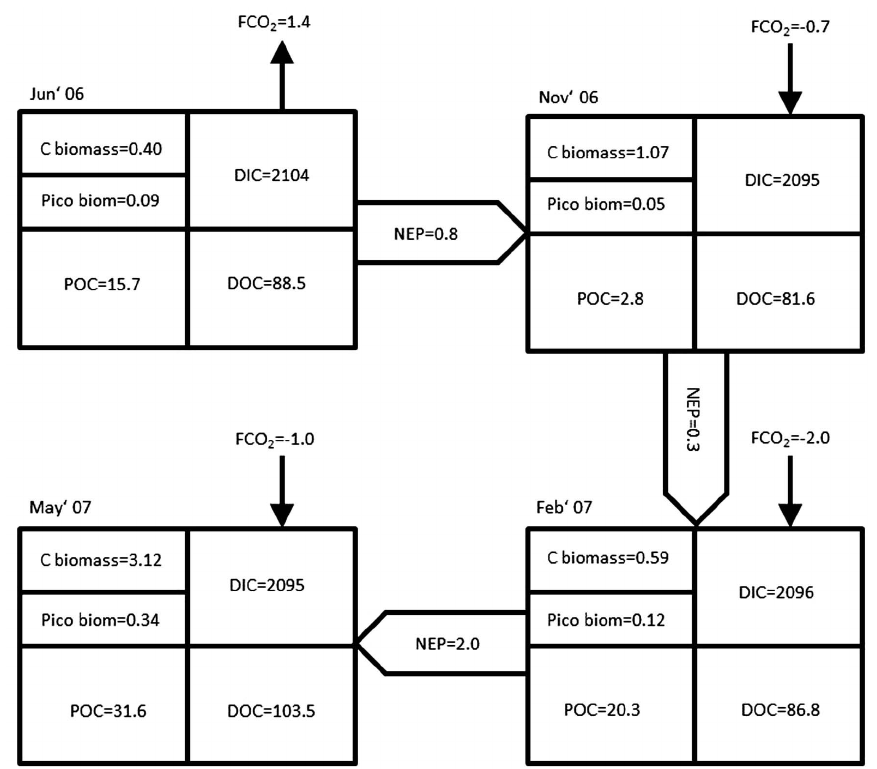
Fig. 7. – Schematic diagram showing the carbon budget for a box model of the continental shelf of the Gulf of Cádiz. Each box represents one season. Units are in µmol kg –1 for dissolved inorganic carbon (DIC), dissolved organic carbon (DOC), particulate organic carbon (POC), total phytoplankton carbon biomass (C biomass) and picophytoplankton carbon biomass (Pico biom). The net ecosystem production (NEP) and air-sea CO flux (FCO ) are in mmol m –2 d –1 . A negative FCO value indicates air-to-sea flux and a positive flux value represents the net 2 2 2 CO exchange from the water body to the 2